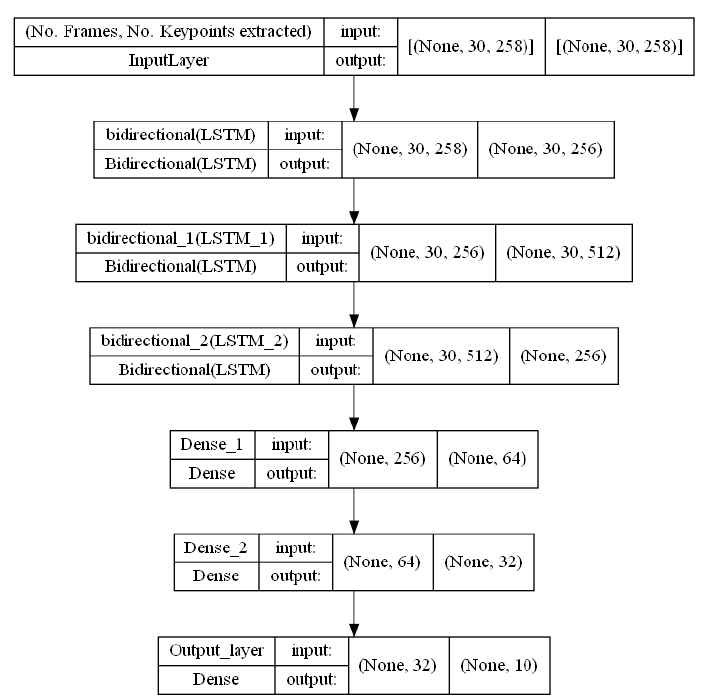
Figure 6. Bi-LSTM model